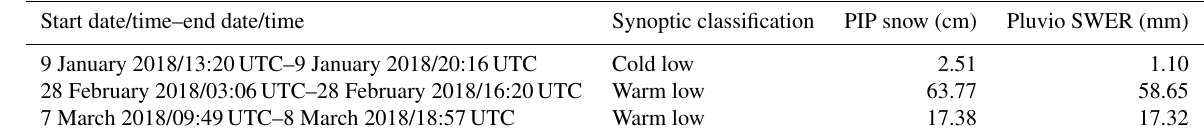
Table 1. Selected snowfall events during ICE-POP 2018. Synoptic classification is from Kim et al. (2021). SWER indicates snow water equivalent rate.